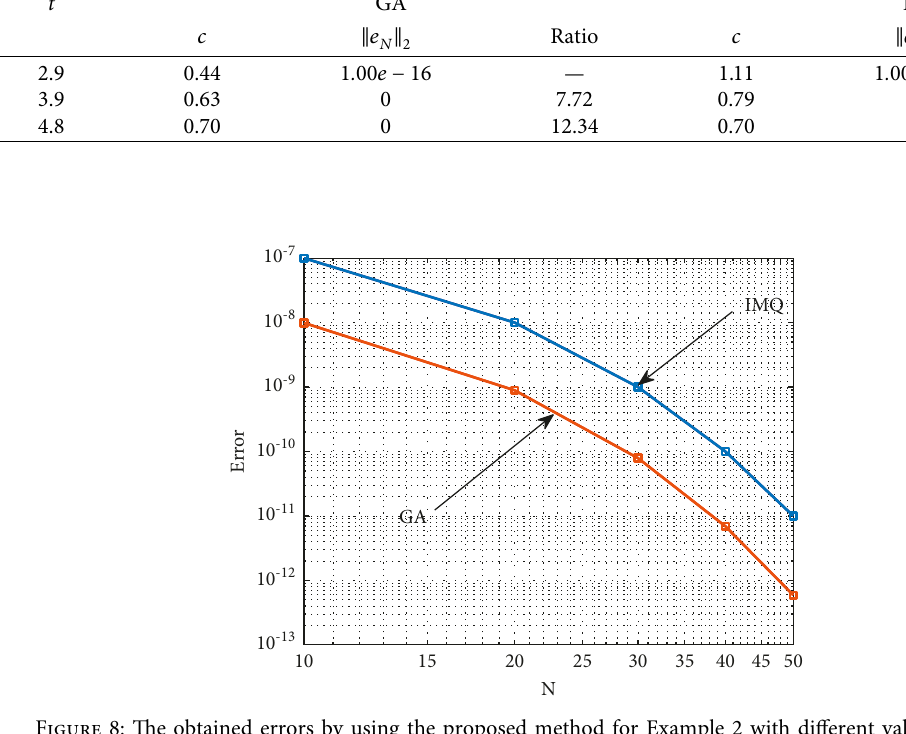
Figure 8: The obtained errors by using the proposed method for Example 2 with different values of N .